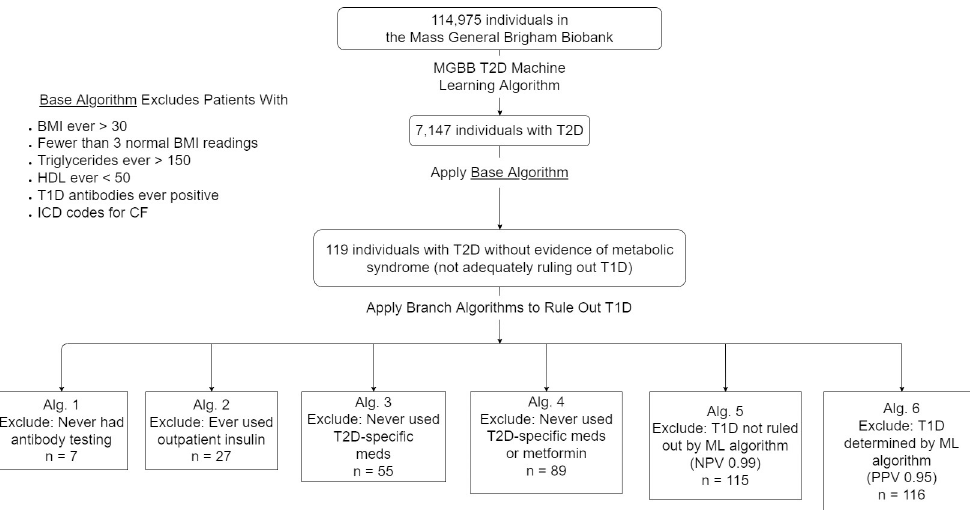
Fig 1. Flow diagram–base and branch algorithms for identifying patients with possible atypical diabetes (AD) in the Massachusetts General Brigham (MGB) Biobank. MGBB: Mass-General Brigham Biobank; T2D: type 2 diabetes; BMI: body mass index; HDL: high-density lipoprotein; T1D: type 1 diabetes; NPV: negative predictive value; PPV: positive predictive